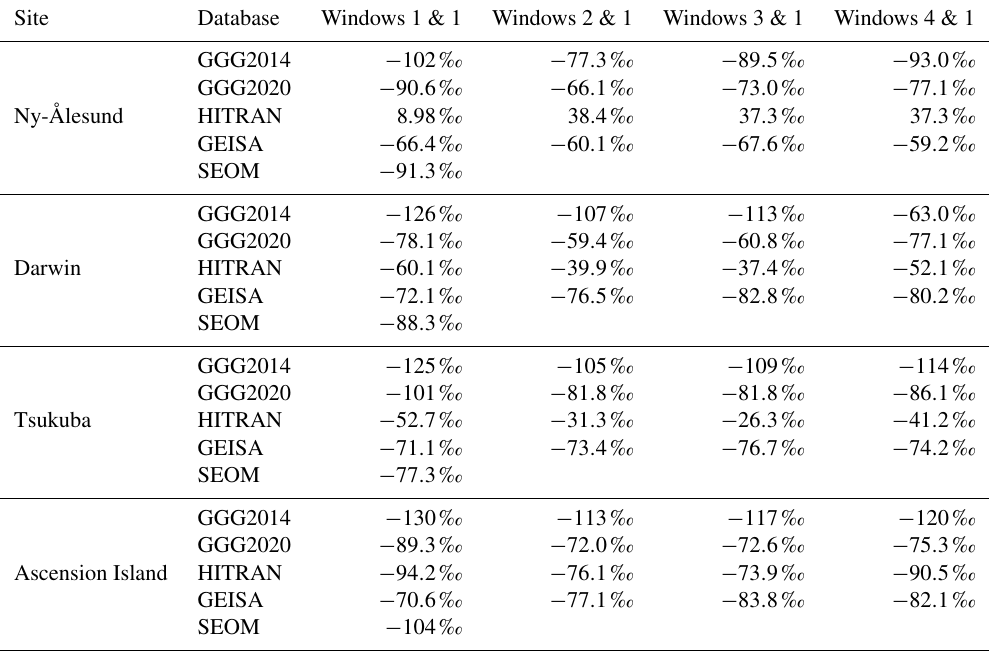
Table 4. Averaged values of δ 13 C from all TCCON sites for all possible combinations of 12 CH 4 with window 1 of 13 CH 4 for each spectral database.